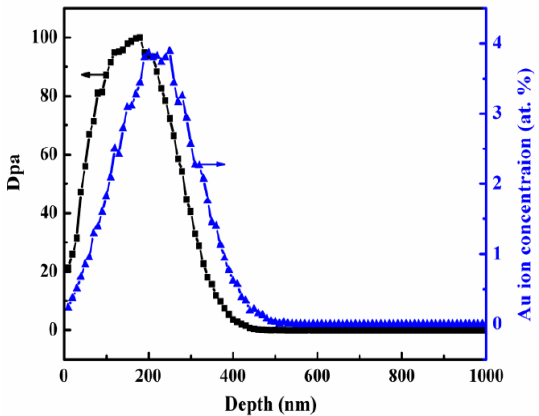
Figure 2. The predicted SRIM profile of the displacement damage and implanted Au ion concentra ‐